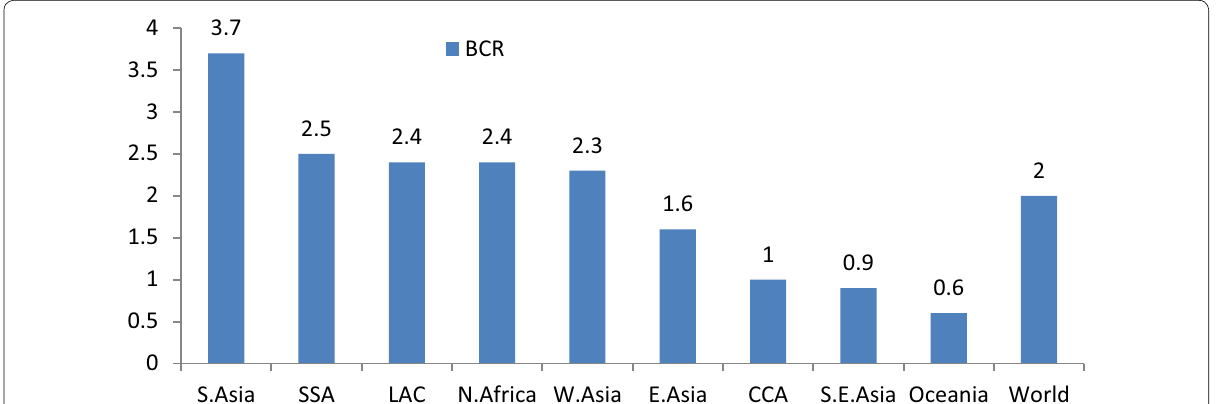
Fig. 5 BCR of improved access to water supply (US$ return per US$ invested) Source: Author’s compilation based on World Health Organization